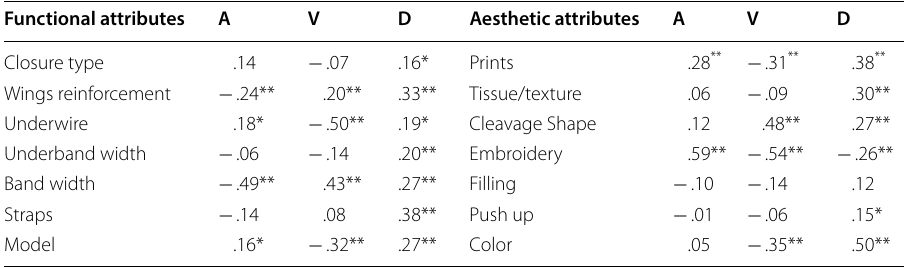
A Arousal; V Valence; D Dominance ** p < .001 and * p < .05